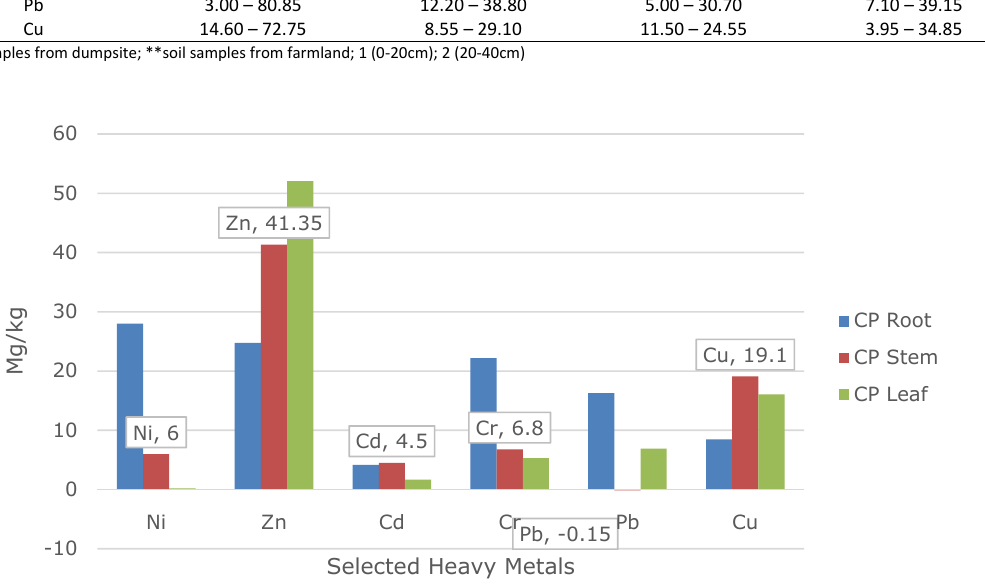
Fig. 3: Concentration of heavy metals in Carica papaya